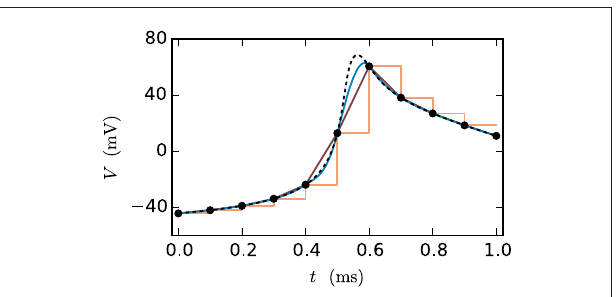
FIGURE 2 | Approximations of the membrane potential. The dashed black curve shows the membrane potential representing an action potential (spike) and the black dots indicate the grid points used for the approximation (step size 0 . 1 ms ). The displayed approximations are: piecewise constant (orange), linear (dark-red) and cubic (blue).